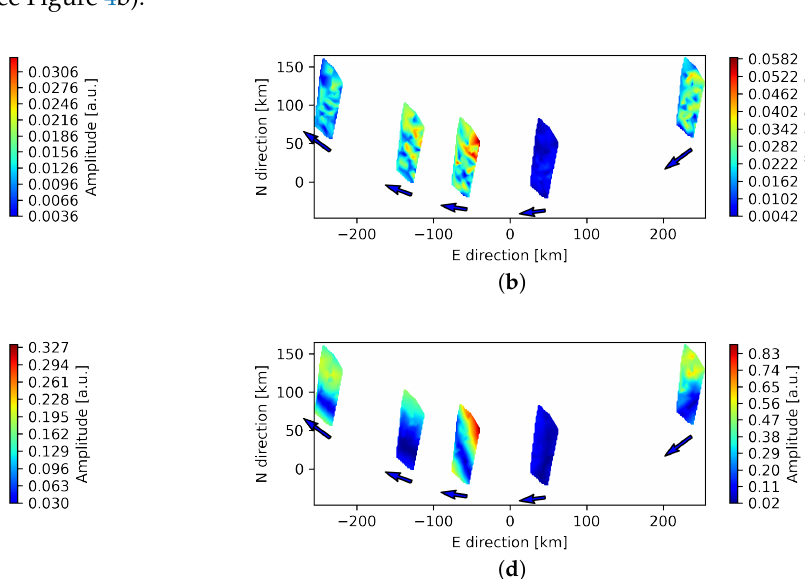
Figure 6. Spatial distribution of amplitudes for remote stations of L79324 at 3, 4, 12 and 27 min central periods (panels ( a – d ), respectively). Arrows indicate the direction of LOS propagation.